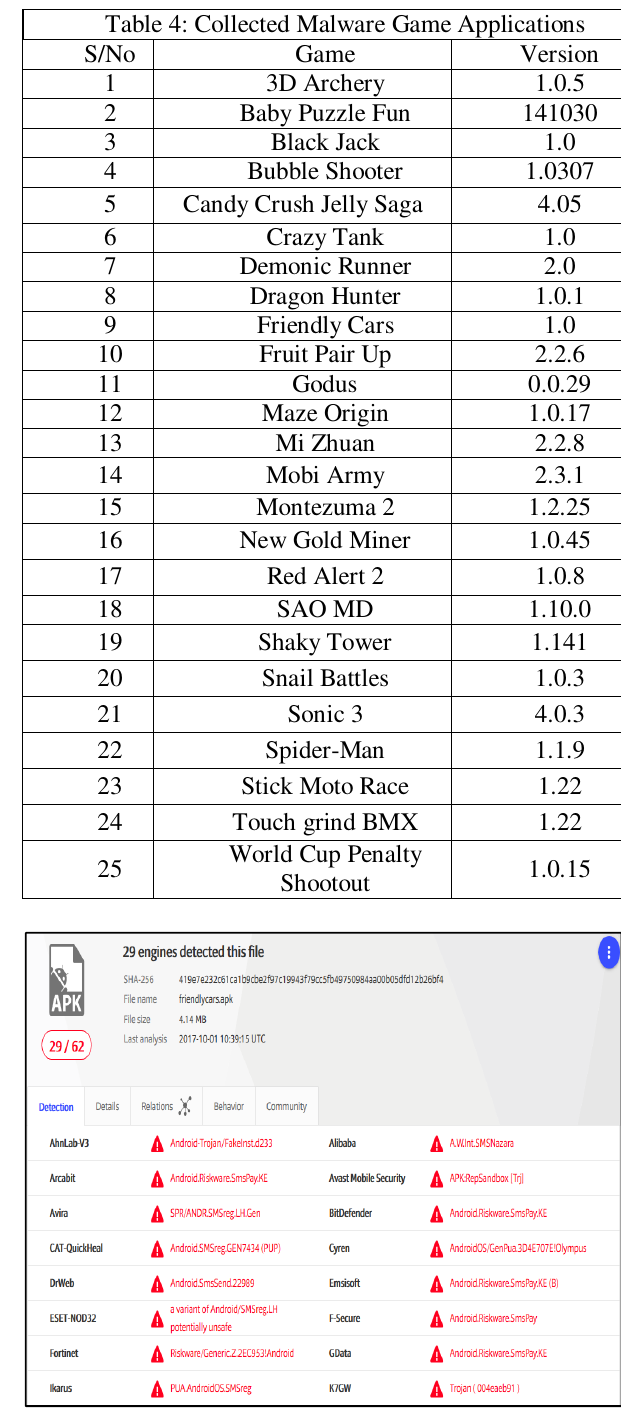
Table 4: Collected Malware Game Applications